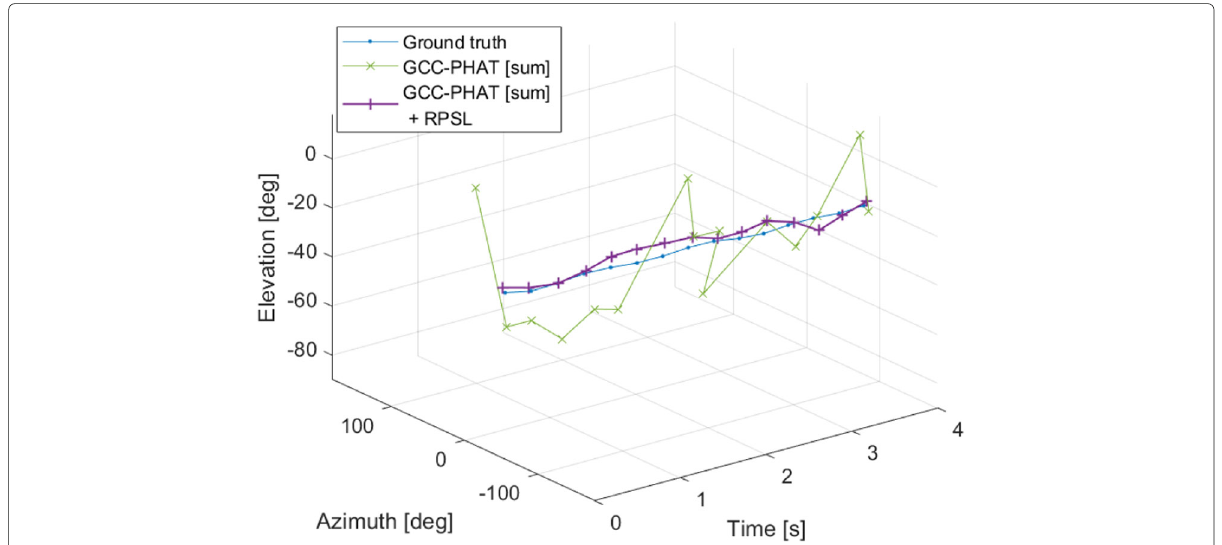
Fig. 13 Example of localisation path estimated for flying UAV broadband sound source (task 2) case 18 [1], using the baseline and proposed method (RPSL